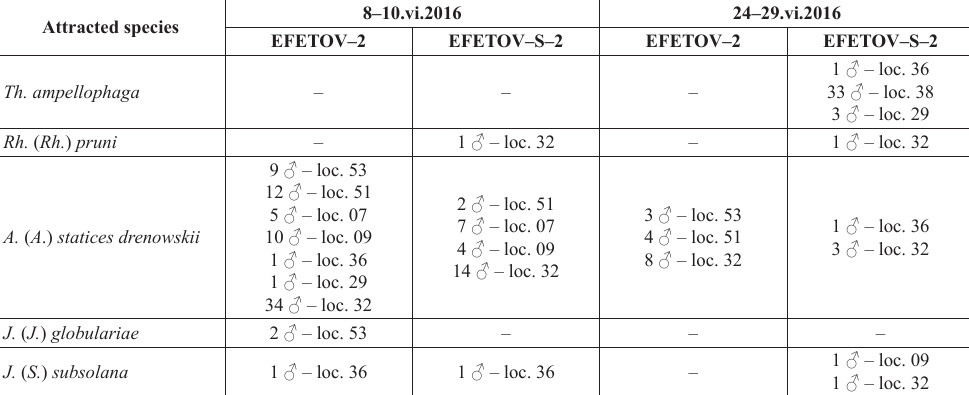
Table 1. Males of attracted Procridinae